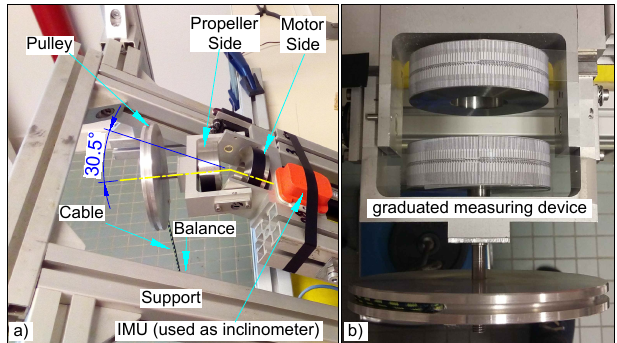
Figure 5. Experimental setup to measure the propeller side rotor torque T h ( a ) α = 30.5 ◦ . ( b ) α = 0 ◦ .